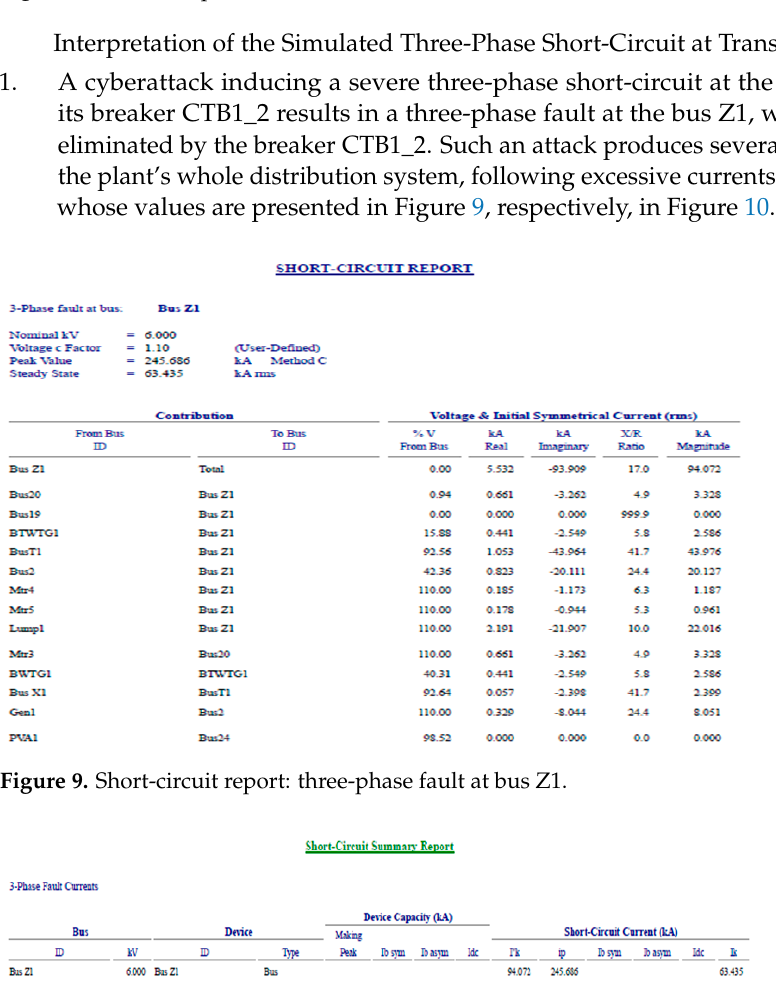
Figure 8. Percent impedance values for T5.